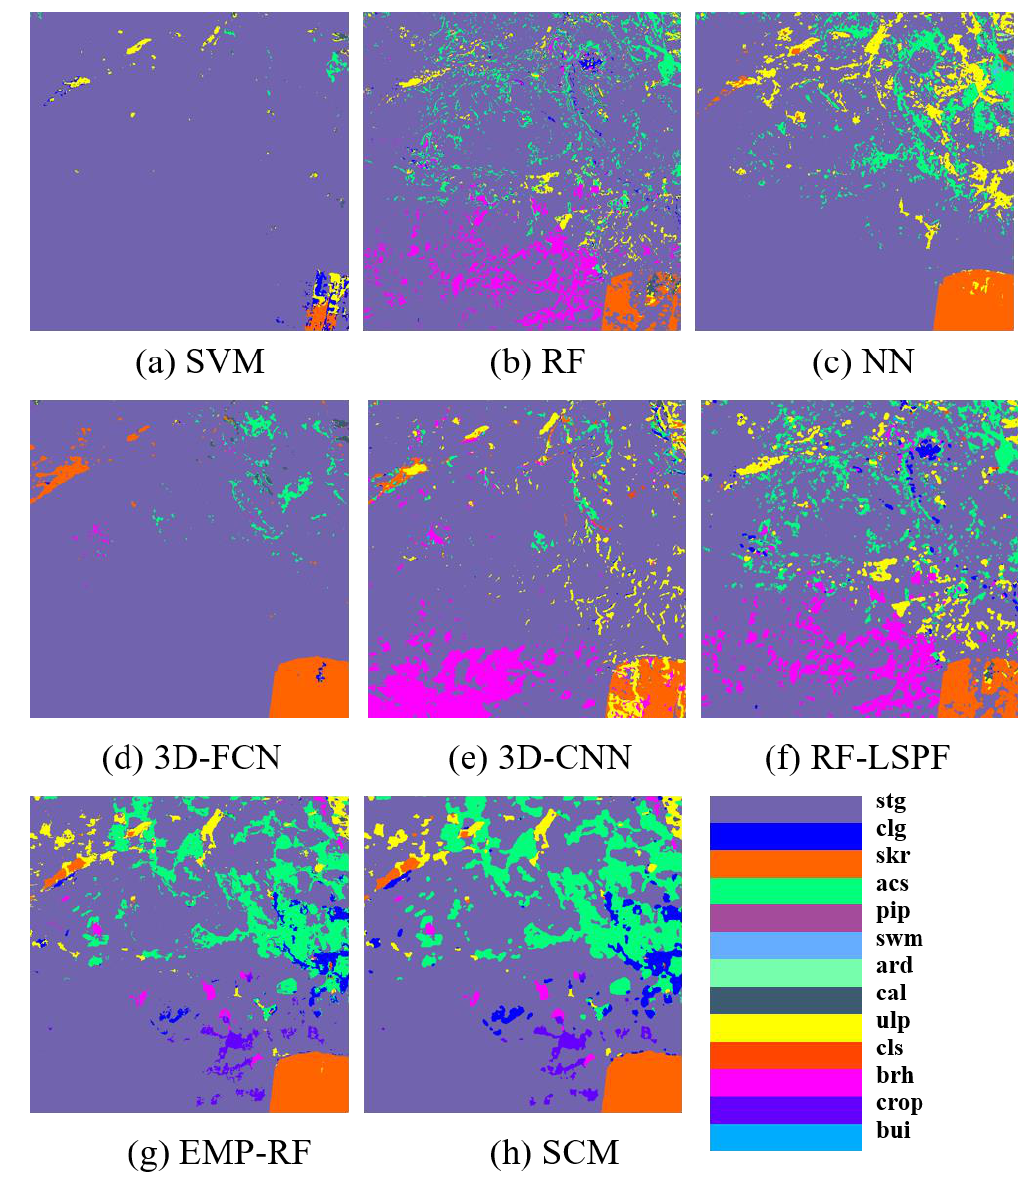
Figure 7. Typical taxonomic region B of grassland communities in Xilinhot. ( a – h ) represent the classi- fication results of SVM, RF, NN, 3D-FCN, 3D-CNN, RF-LSPF, EMP-RF, SCM methods, respec- tively.